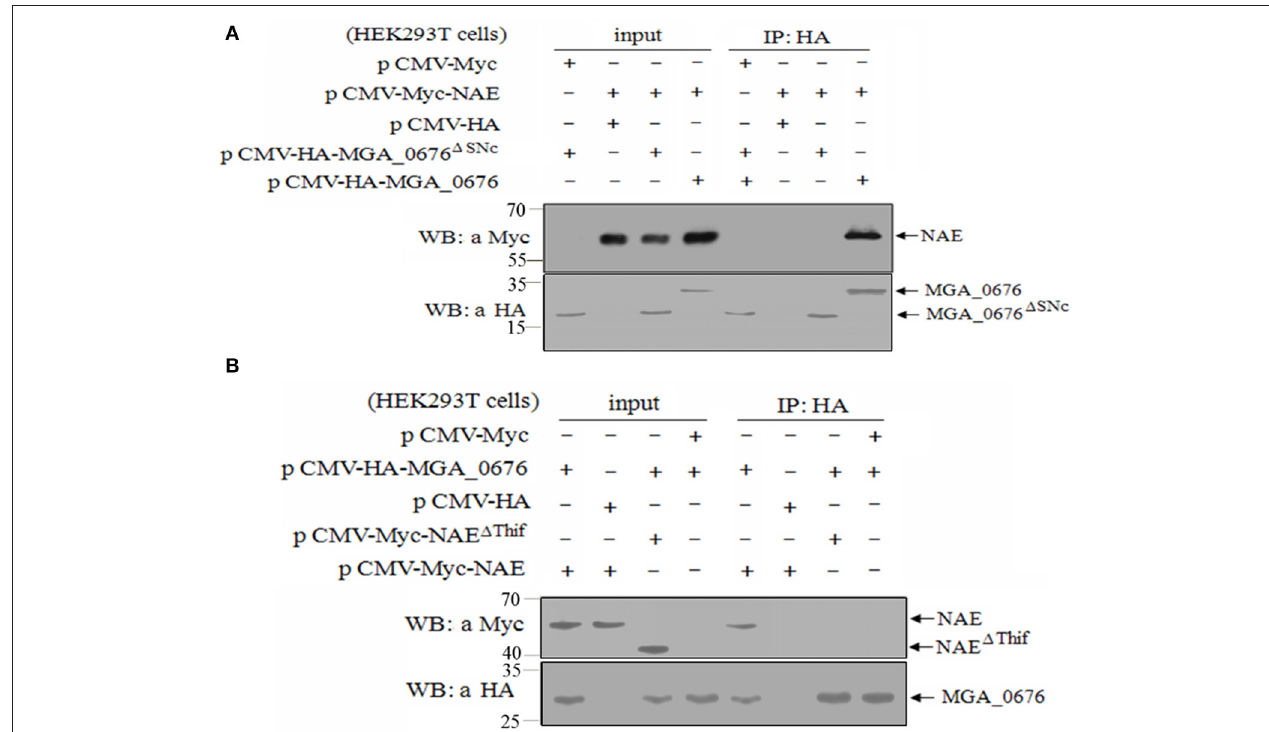
FIGURE 4 | The SNC region of MGA_0676 interacts with the Thif region of NAE. (A) Endogenous NAE cannot interact with MGA_0676 1 SNC (The SNC portion of MGA_0676, from amino acids 92 to 221 was deleted). HEK293T cells were transfected with full-length HA-MGA_0676 and HA-MGA_0676 1 SNC molecules or empty vectors. Twenty-four hours after transfection, cell lysates were prepared and IP with anti-HA monoclonal antibody. The pellets were examined by western blotting using anti-Myc antibody. (B) Endogenous NAE 1 Thif cannot interact with MGA_0676. HEK293T cells were transfected with full-length Myc-NAE and Myc-NAE 1 Thif (The Thif region of NAE from amino acids 29 to 166 was deleted) molecules or empty vectors. Twenty-four hours after transfection, cell lysates were prepared and IP with anti-HA monoclonal antibody. The pellets were examined by western blotting using anti-Myc antibody.